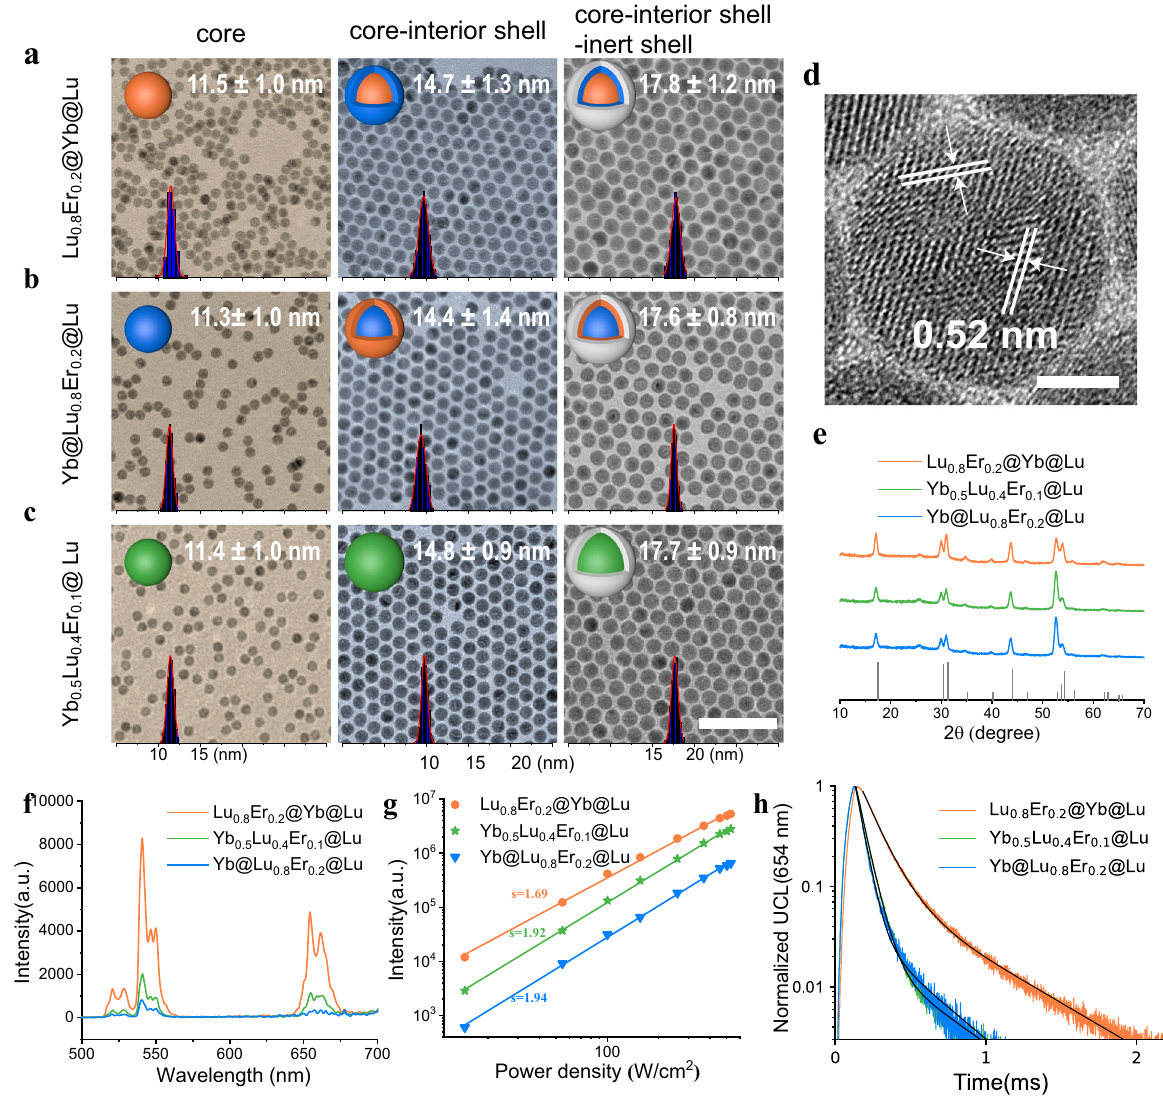
Fig. 2 | Characterizations of outside-in, inside-out, and local energy transfer core-interior shell-inert shell UCNPs. a – c Representative TEM images of Lu 0.8 Er 0.2 @Yb@Lu, Yb@Lu 0.8 Er 0.2 @Lu and Yb 0.5 Lu 0.4 Er 0.1 @ Lu. Shown from the left to right are the core, the core-interior-shell and the core-interior-shell-inert shellarchitecturewithhistogramsofsizedistributioninblueandGaussian fi ttingin redoverlayedatthebottomofeachTEMimage.Morethan fi veTEMimagesofeach sample were included for statistical analysis, the results were presented as mean ± standarddeviation,allTEMimagesshareascalebarof100nm. d HR-TEMimage of Lu 0.8 Er 0.2 @Yb@Lu, the lattice spacing is 0.52nm, corresponding to the (1010)